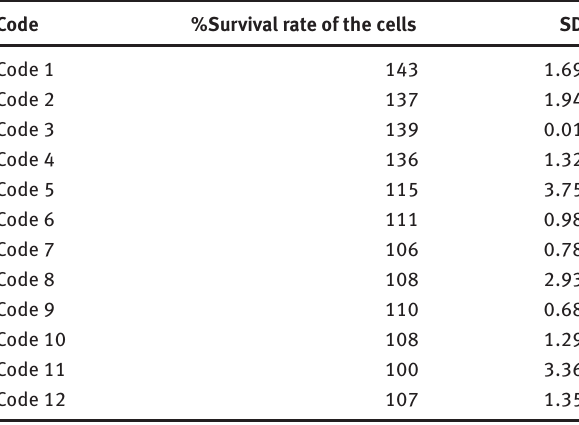
Table 6: %Survival rate of the cells as measured by cytotoxicity test.